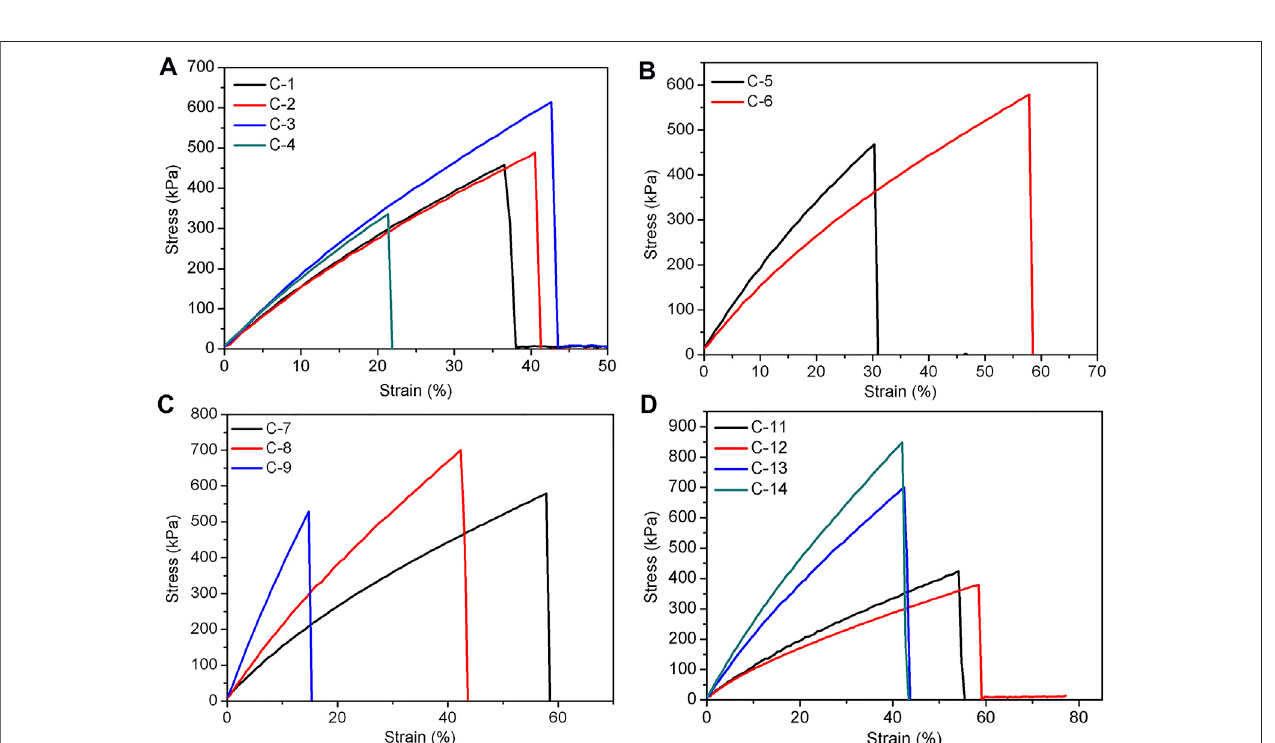
Frontiers in Chemistry |